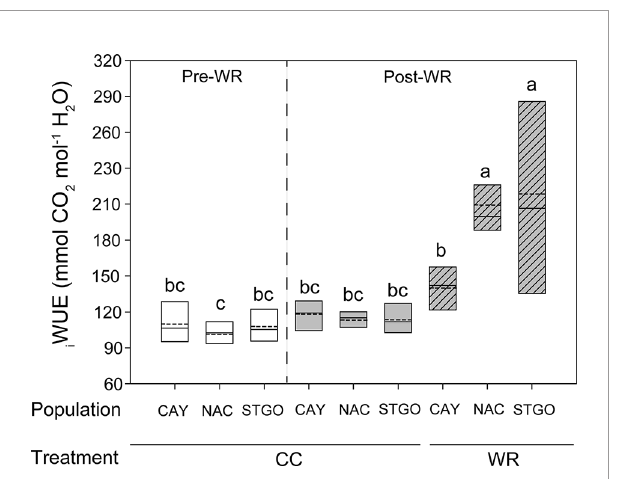
FIGURE 2 | Signi fi cant triple interaction between measurement time, population, and water restriction treatment affected intrinsic water use ef fi ciency (iWUE, mmol CO 2 mol -1 H 2 O) in Cryptocarya alba plants. Bottom and top boundaries of the boxes represent the 25 th and 75 th percentiles, respectively. The solid line in the center of each box represents the mean value and the dashed line represents the median value. Different letters indicate signi fi cant differences among measurement time, populations, and water restriction treatment according to Tukey at p<0.05. Pre-WR, measurement before the onset of water restriction; Post-WR, measurement at the end of the experiment; CC, container capacity; WR, water restriction;